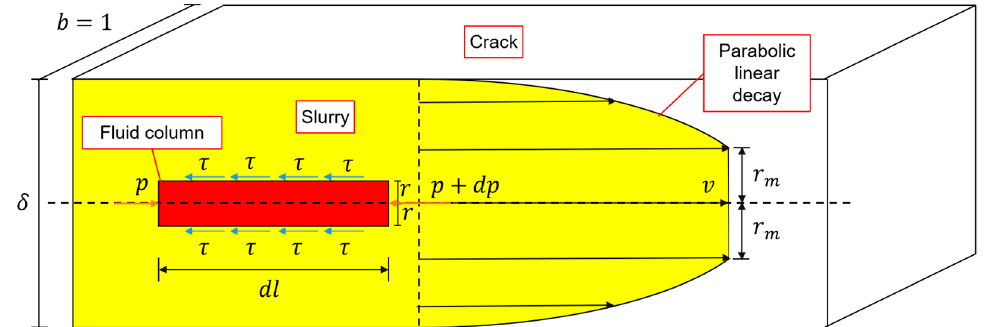
Figure 1. Bingham fluid flow in a crack.